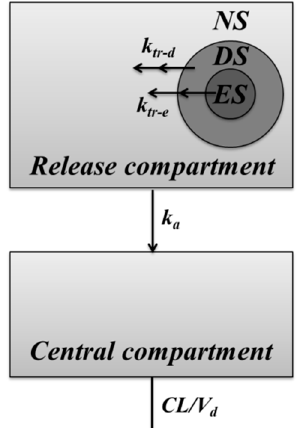
Figure 2. Schematic representation of the in vitro–in vivo correlation (IVIVC) model of microspheres. Solid lines indicate the elimination or the distribution of leuprolide.